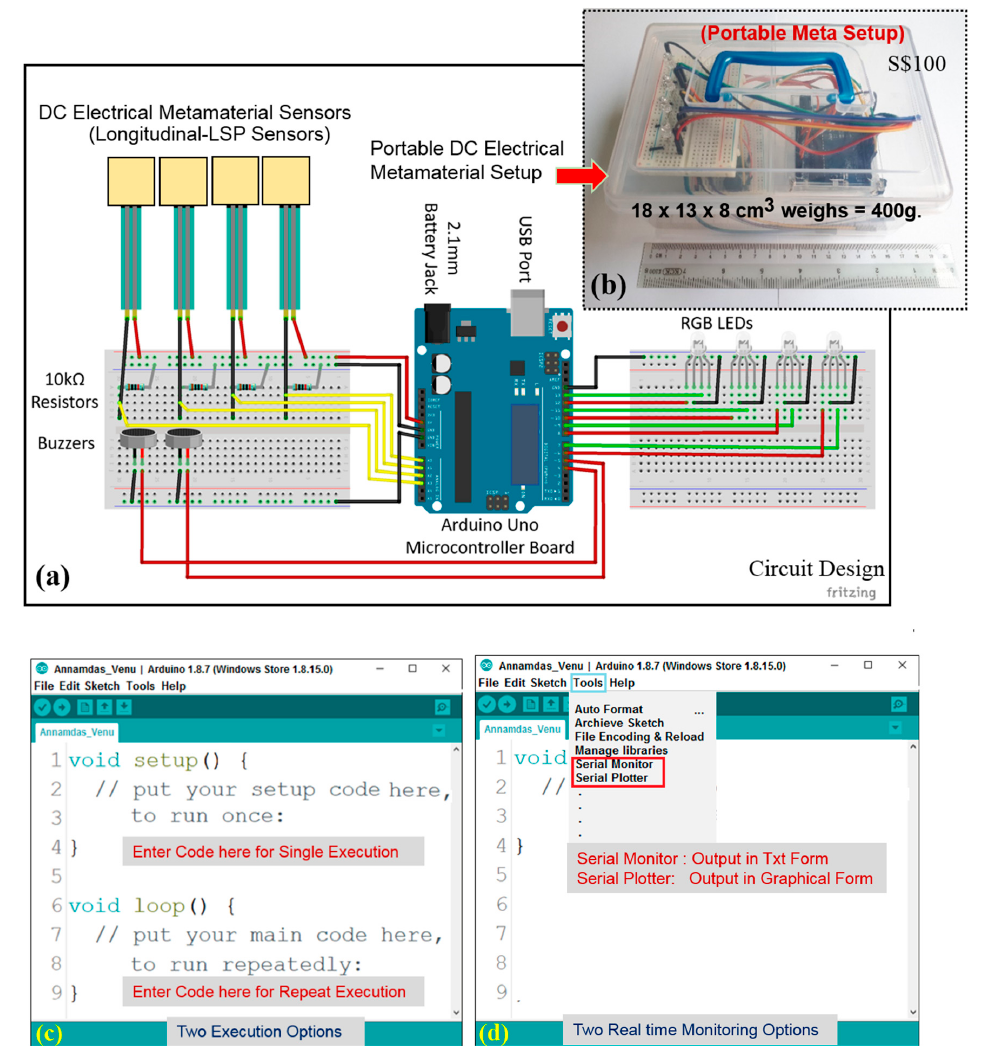
Figure 7. Portable Meta setup and software screen information. ( a ) Information of circuit diagram of kit; ( b ) photo of kit, in a ready to carry portable case; ( c ) code execution window screen; and ( d ) real time execution window screen.